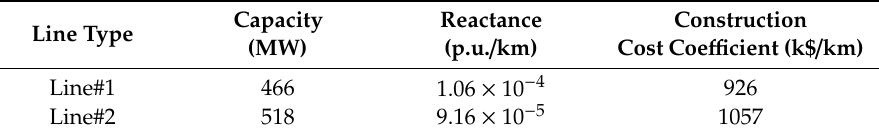
Table 2. Data for Candidate Transmission